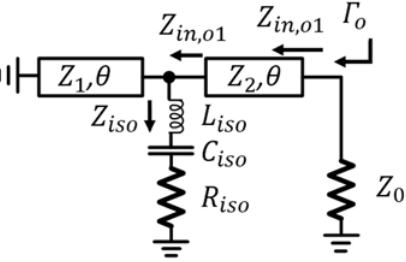
Figure 3. Bisected network with short ‐ circuit bisecting plane at the plane of symmetry for odd ‐ mode analysis.